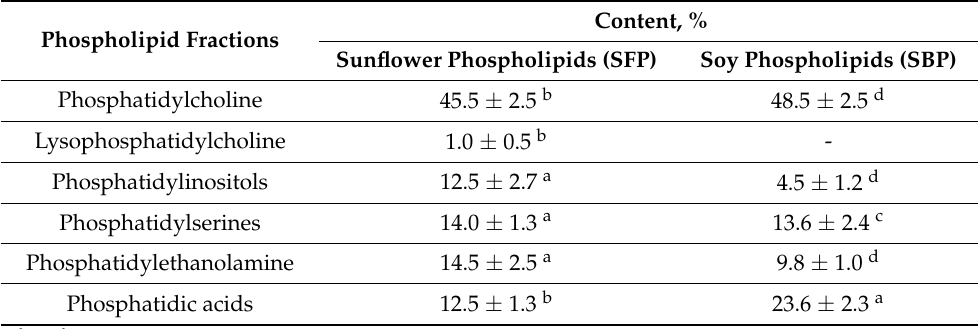
Table 5. Fractional composition of the phospholipids under study.